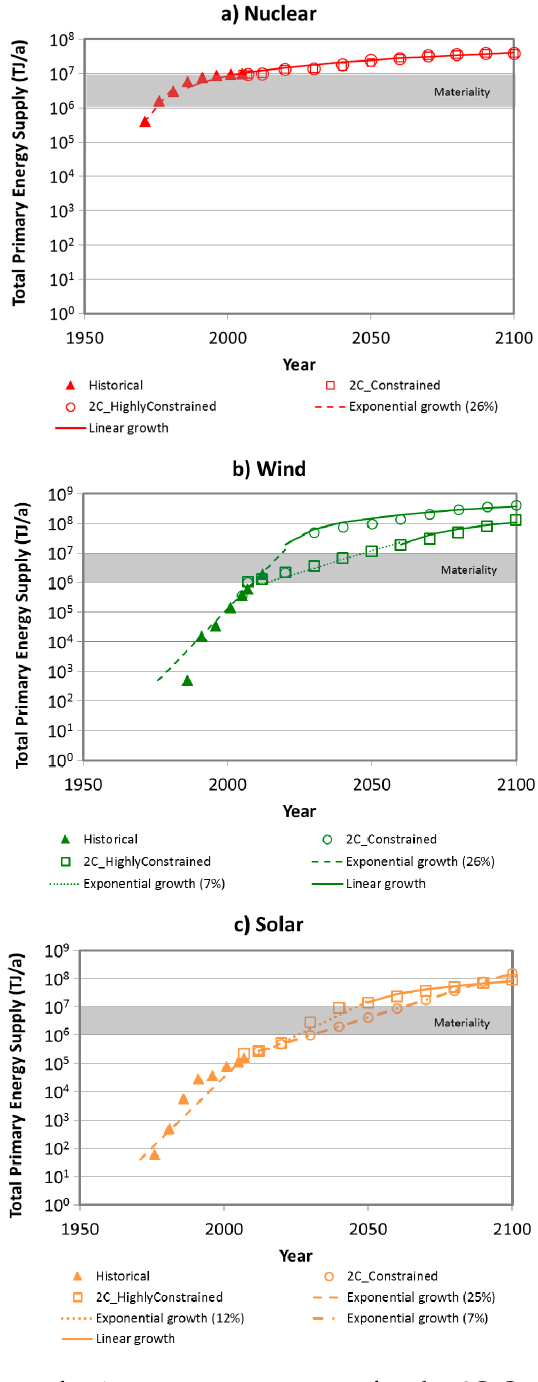
Figure 7. Deployment of primary energy resources for the 2C_Constrained scenario the 2C_HighlyConstrained scenario for three key technologies ( a ) Nuclear; ( b ) Wind and ( c ) Solar. Notes: Historical data was estimated from Kramer and Haigh [21]. Future numbers are taken from the TIAM-Grantham scenario projections. Primary energy supply for renewables and nuclear is taken as actual electricity generated.